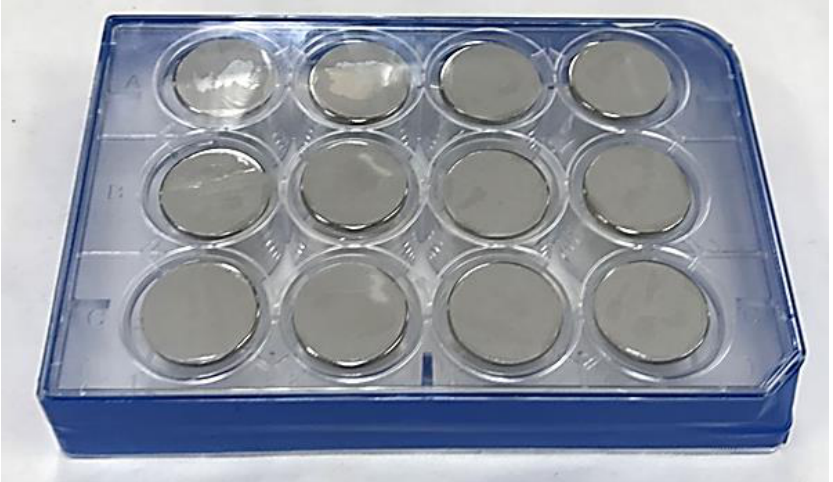
Figure 2. Image of custom-made magnetic-based plate used for magnetic uptake adapted to 12-well culture plates.